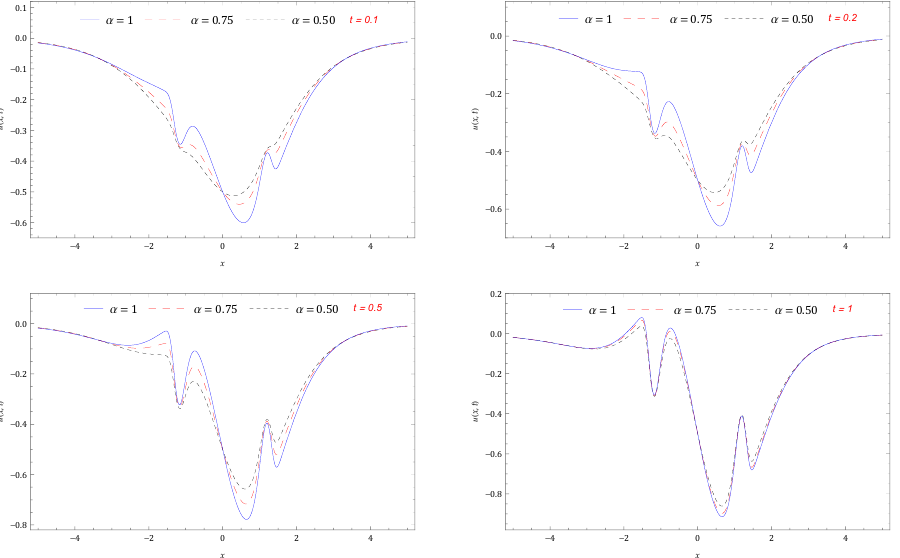
Figure 6. Response of obtained solution with distinct α and time at n = 1 , (cid:125) = − 1 , β = 8 and F r = − 1.